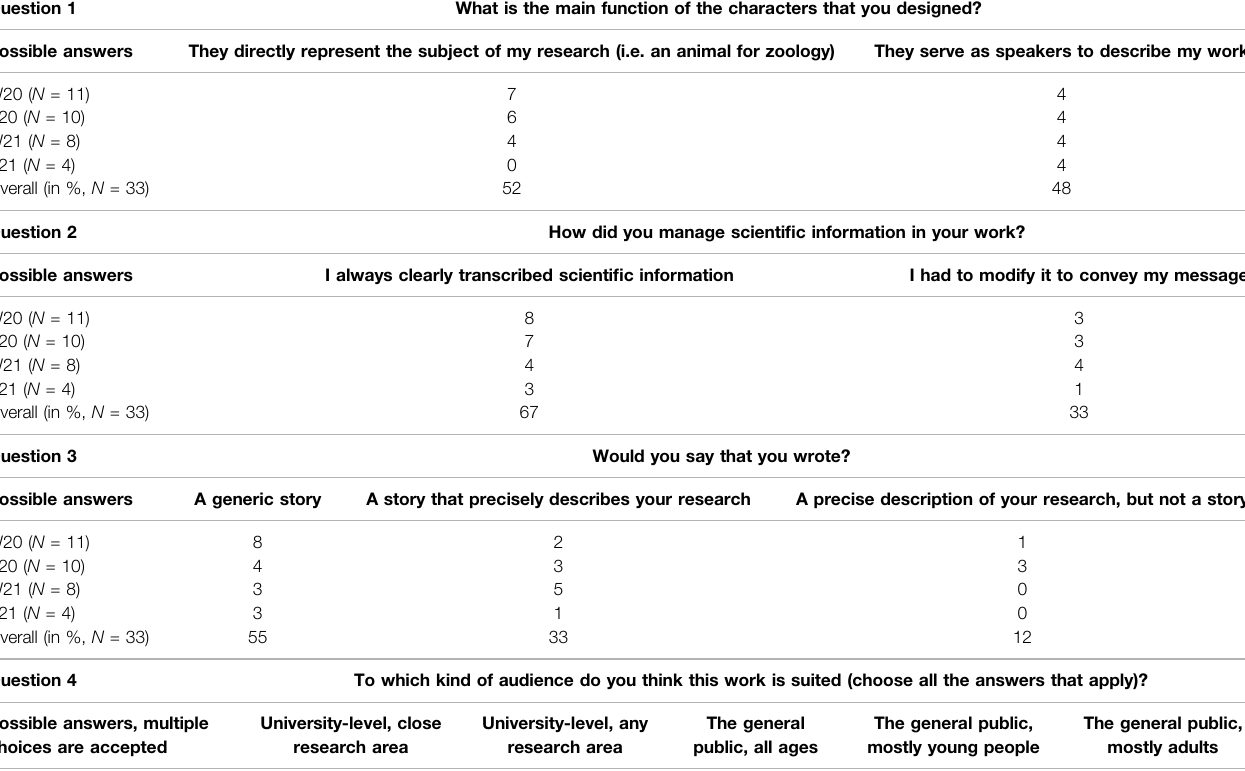
TABLE 3 | Results of the post-course survey over four teaching sessions. Question